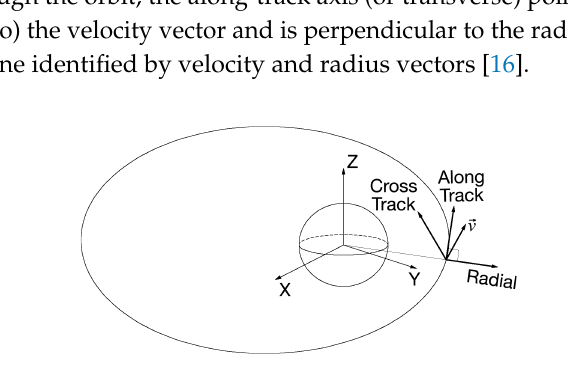
Figure 2. Along-track (A), cross-track (C) and radial